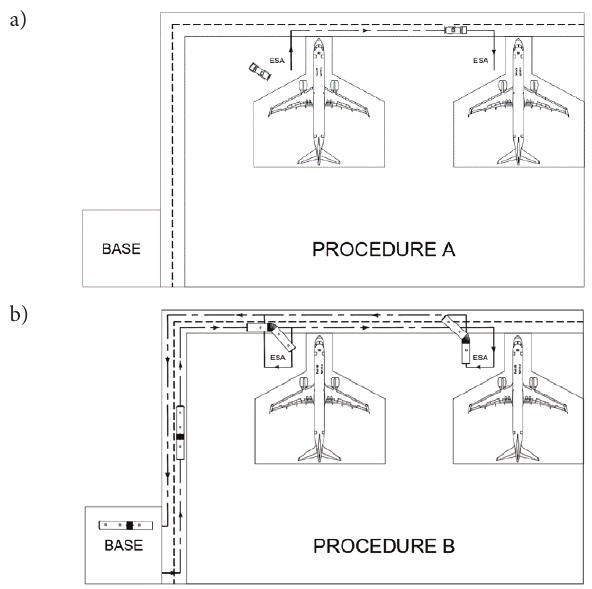
Fi gure 2. Procedures: a – illustration of procedure A between two parking stands; b – procedure B in which vehicles leave the base to assist an aircraft